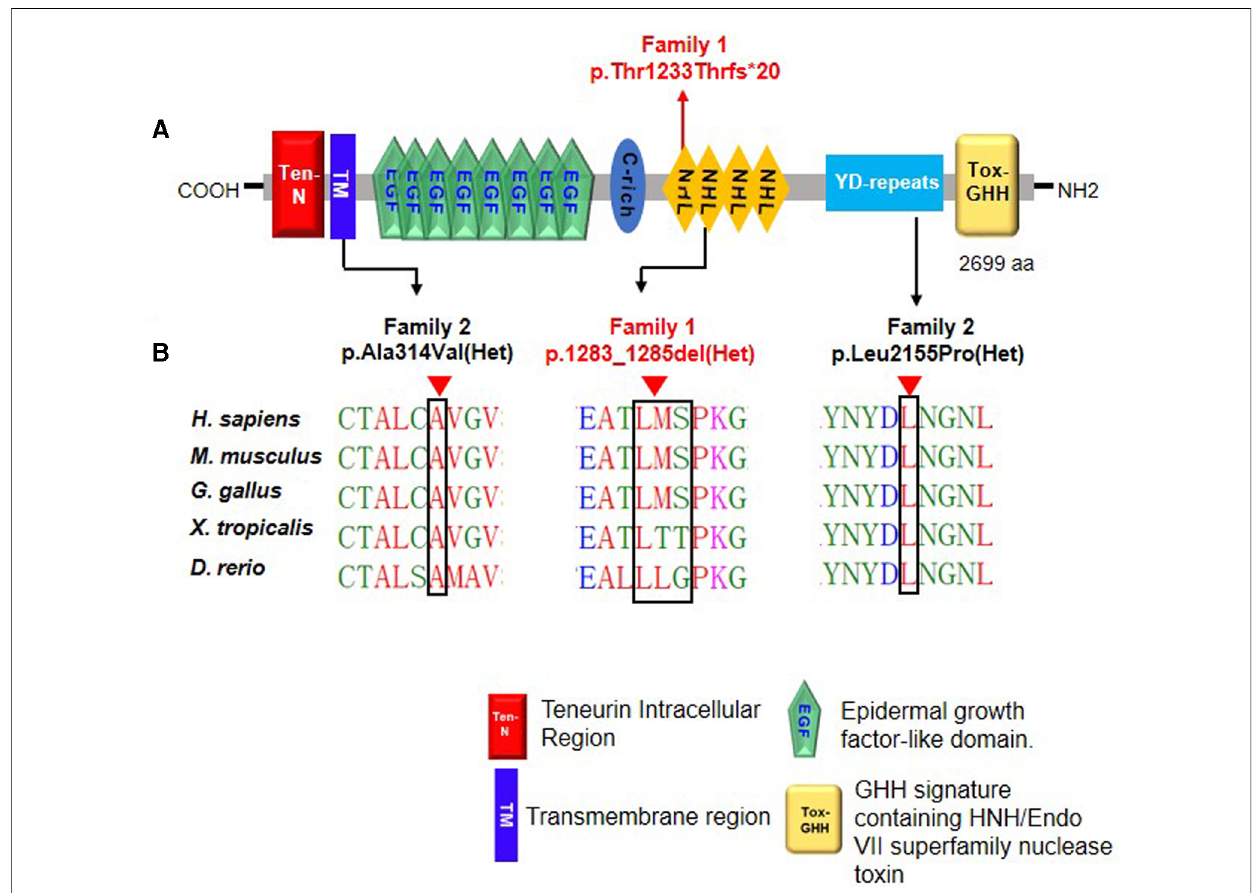
FIGURE 3 Schematic diagram of TENM3 functional domains and TENM3 variants identi fi ed in this study. ( A ) Depicts the protein domain structure of human TENM3 showing the domain position of the index heterozygous TENM3 variants. aa, amino acids. ( B ) Evolutionary conservation of amino acid position Ala1283- Ser1285 and Leu2155 in TENM3 protein across